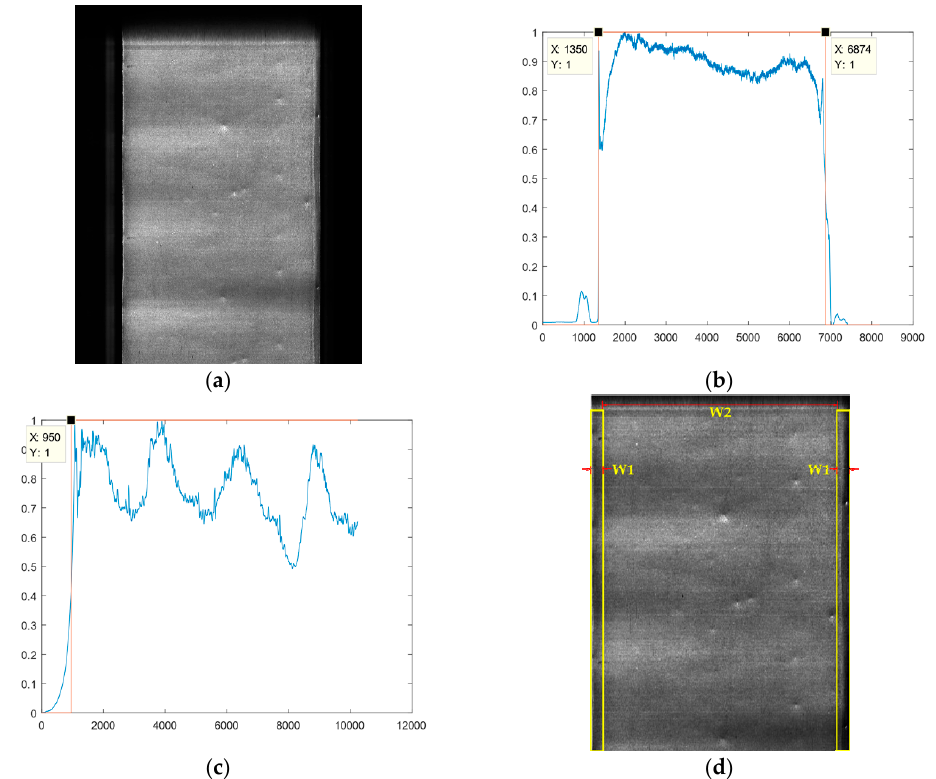
Figure 4. Processing of Region of interest (ROI) extraction. ( a ) Original image (8192 × 10,240 pixels); ( b ) ROI extracted of columns; ( c ) ROI extracted of rows; ( d ) ROI extraction finished (5525 × 9291 pixels).